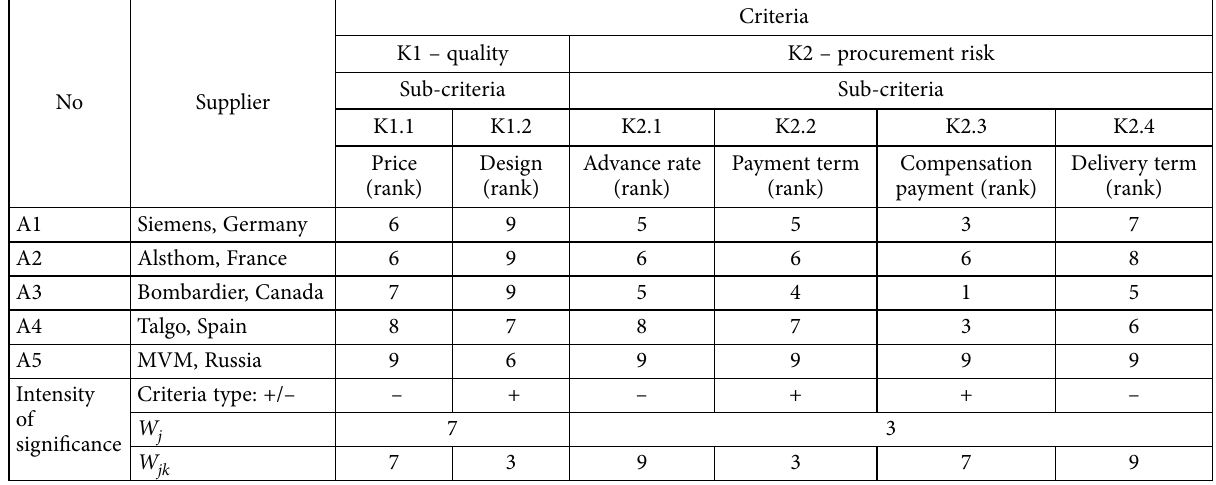
Table 8. Decision table – supplier choice, based on the procurement contract